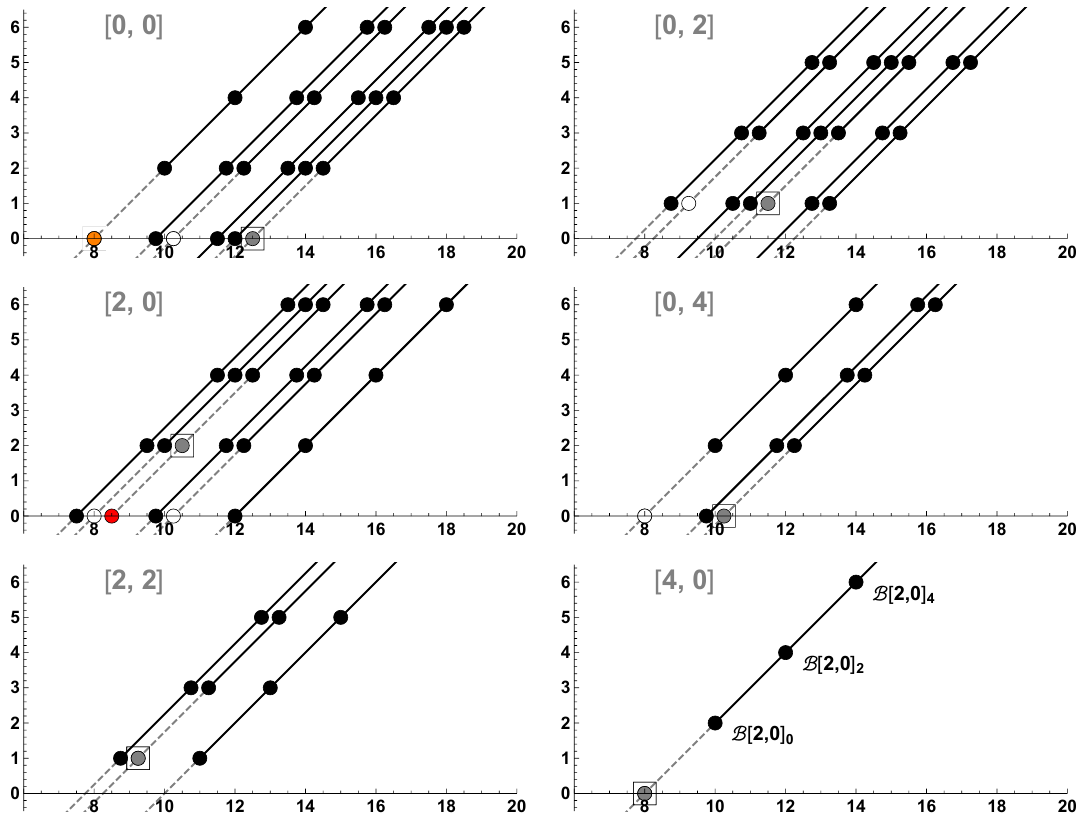
Figure 3. (∆ , ‘ ) planes: B [2 , 0] ‘ − 2 trajectories (lines and dots) and D [4 , 0] operators